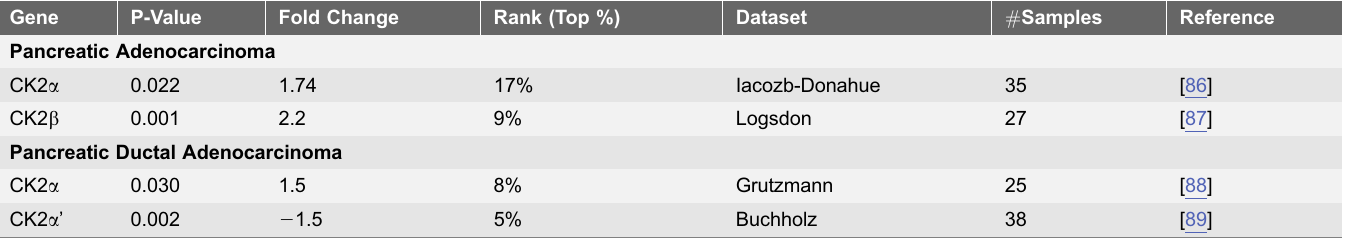
Table 7. Changes in CK2 gene expression in pancreatic